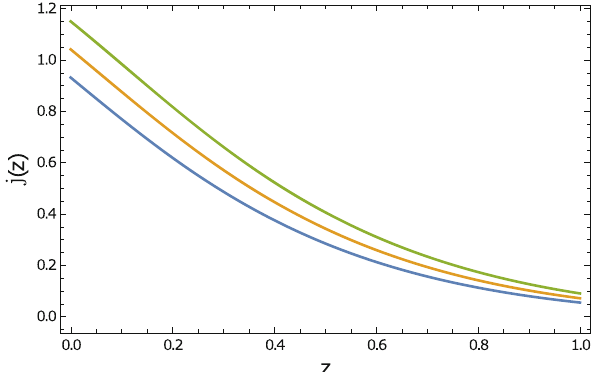
Fig. 7 Jerk parameter, j , as a function of redshift for jerk parameter in Eq. (48); Blue is s = 0 . 85, Yellow is s = 0 . 90 and Green is s = 0 .